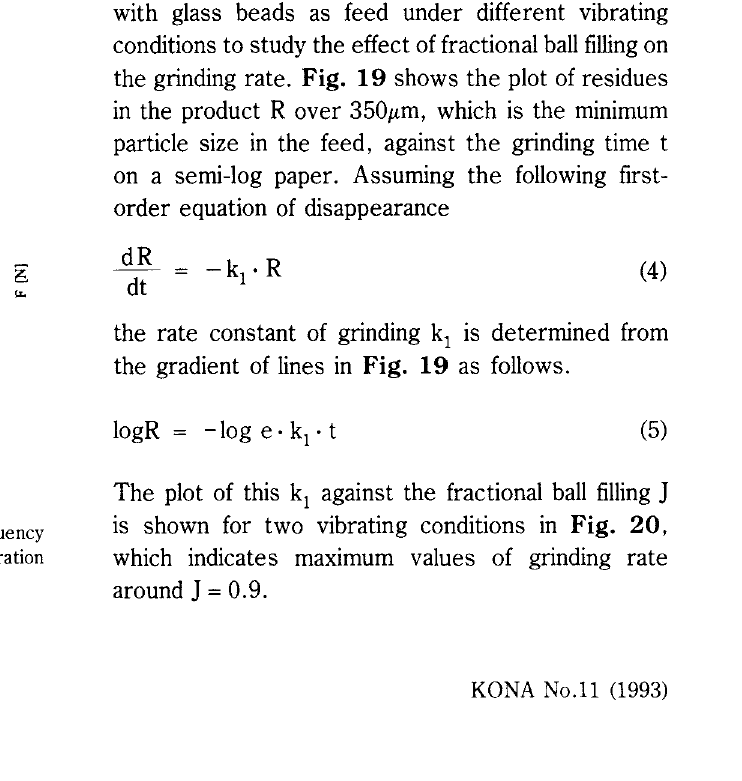
Fig. 16 Effect of vibration amplitude on total collision frequency and average intensity.